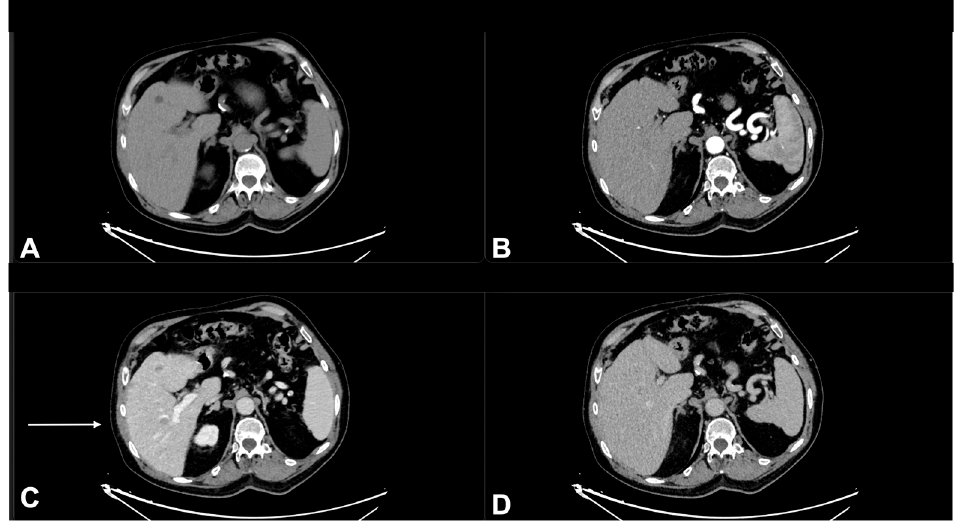
Figure 9. A 78-year-old male patient in treatment with immunotherapy, enhanced CT imaging (128 slices) performed in July 2021. Pre contrast phase CT ( A ), Arterial phase ( B ), Portal phase ( C ), Tardive phase ( D ). In the portal phase ( C ), vague hypodense areas not visible in the other phases of the study, fifth hepatic segment. These areas were suspected of liver metastases from squamous cell carcinoma.